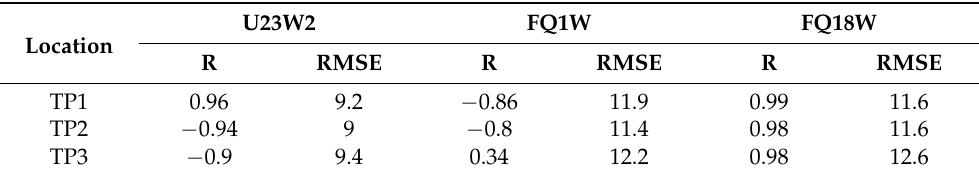
Table 11. Correlation of InSAR measurements from the SBAS analysis and field water level measure- ments using different datasets from Radarsat-2 in Long Point in 2018. U23W2 FQ1W FQ18W Location R RMSE R RMSE